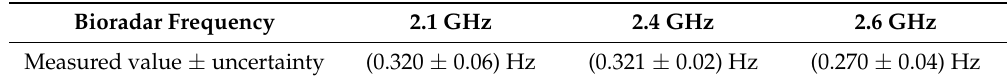
Table 4. Measurement results plus uncertainty